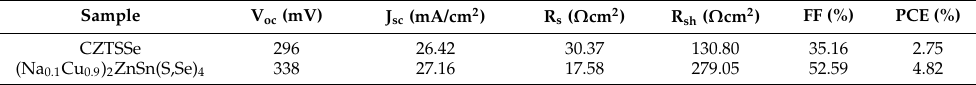
Table 3. The parameters of CZTSSe and Na-doped Cu 2 ZnSn(S,Se) 4 device performance.